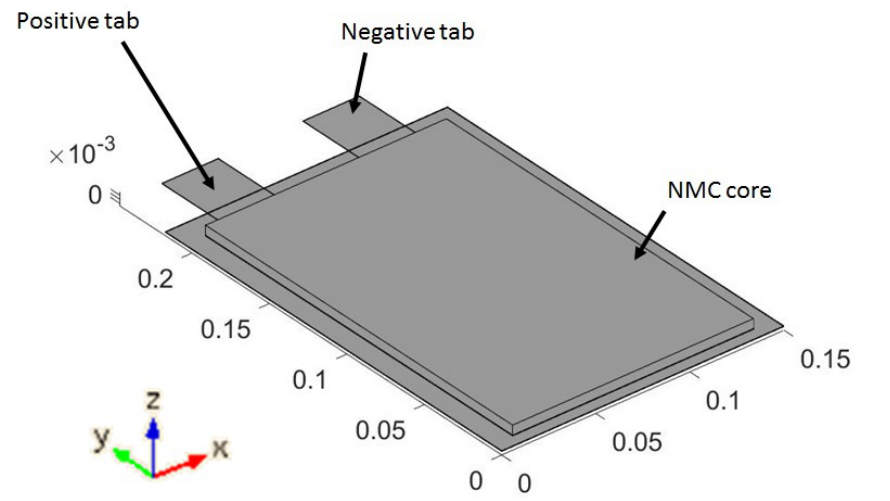
Figure 3. Simple representation of the NMC cell with dimensions in